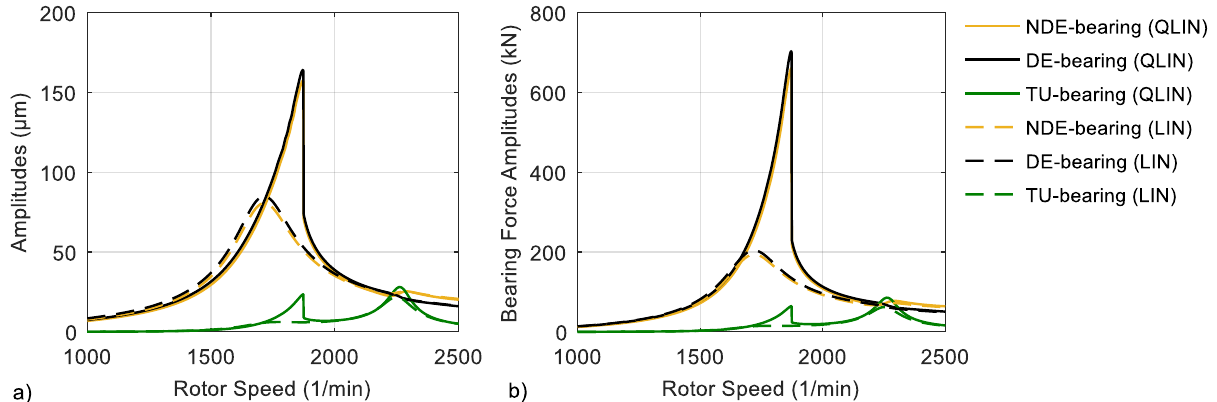
Figure 13. ( a ) Relative bearing amplitudes; ( b ) amplitudes of bearing forces; each for the linear (LIN) and quasi-linear (QLIN) analysis, unbalance G6.3 (40%), variant 1, run-up.